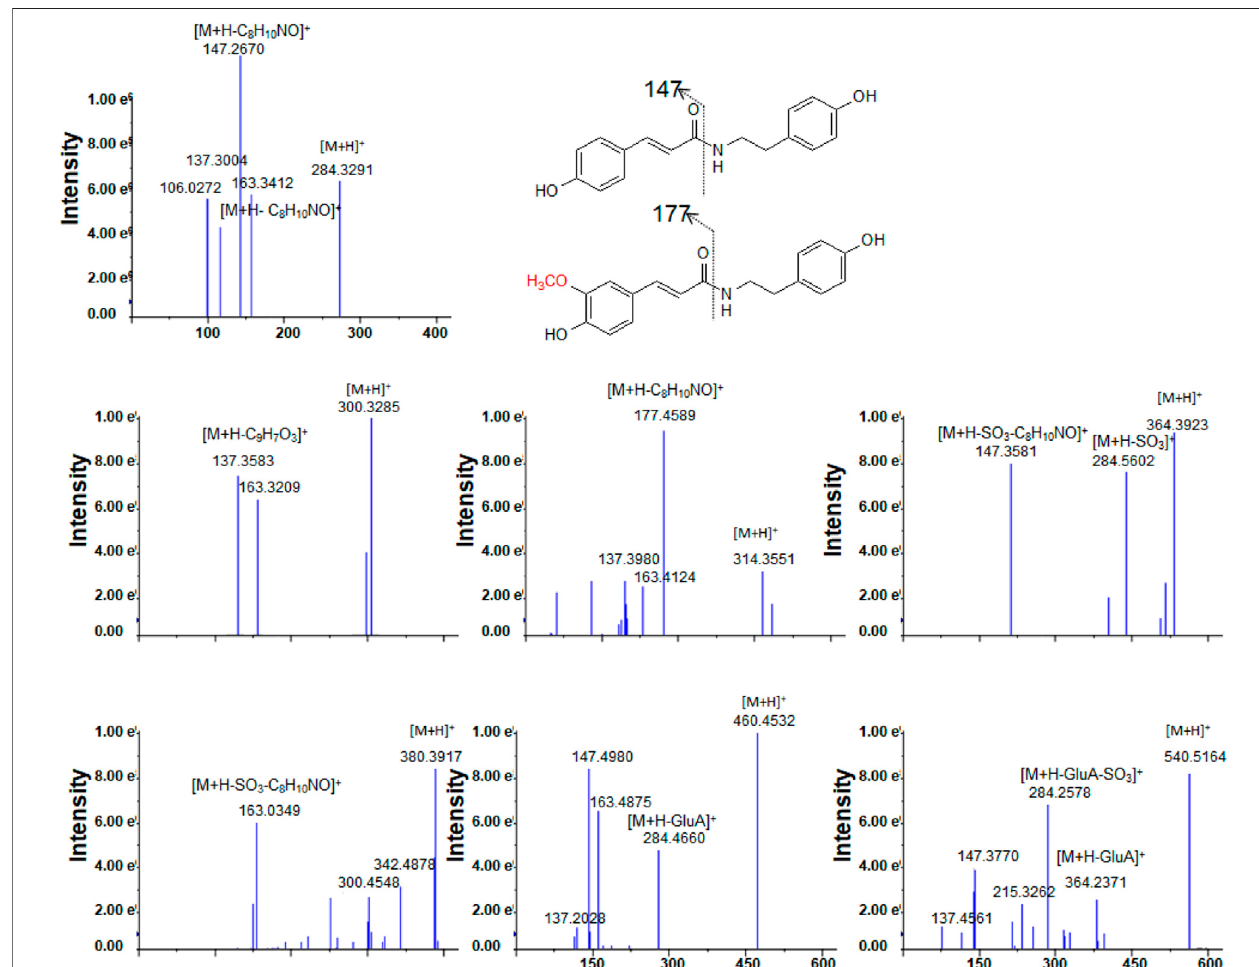
FIGURE 3 | The tandem mass spectra for 1 and its